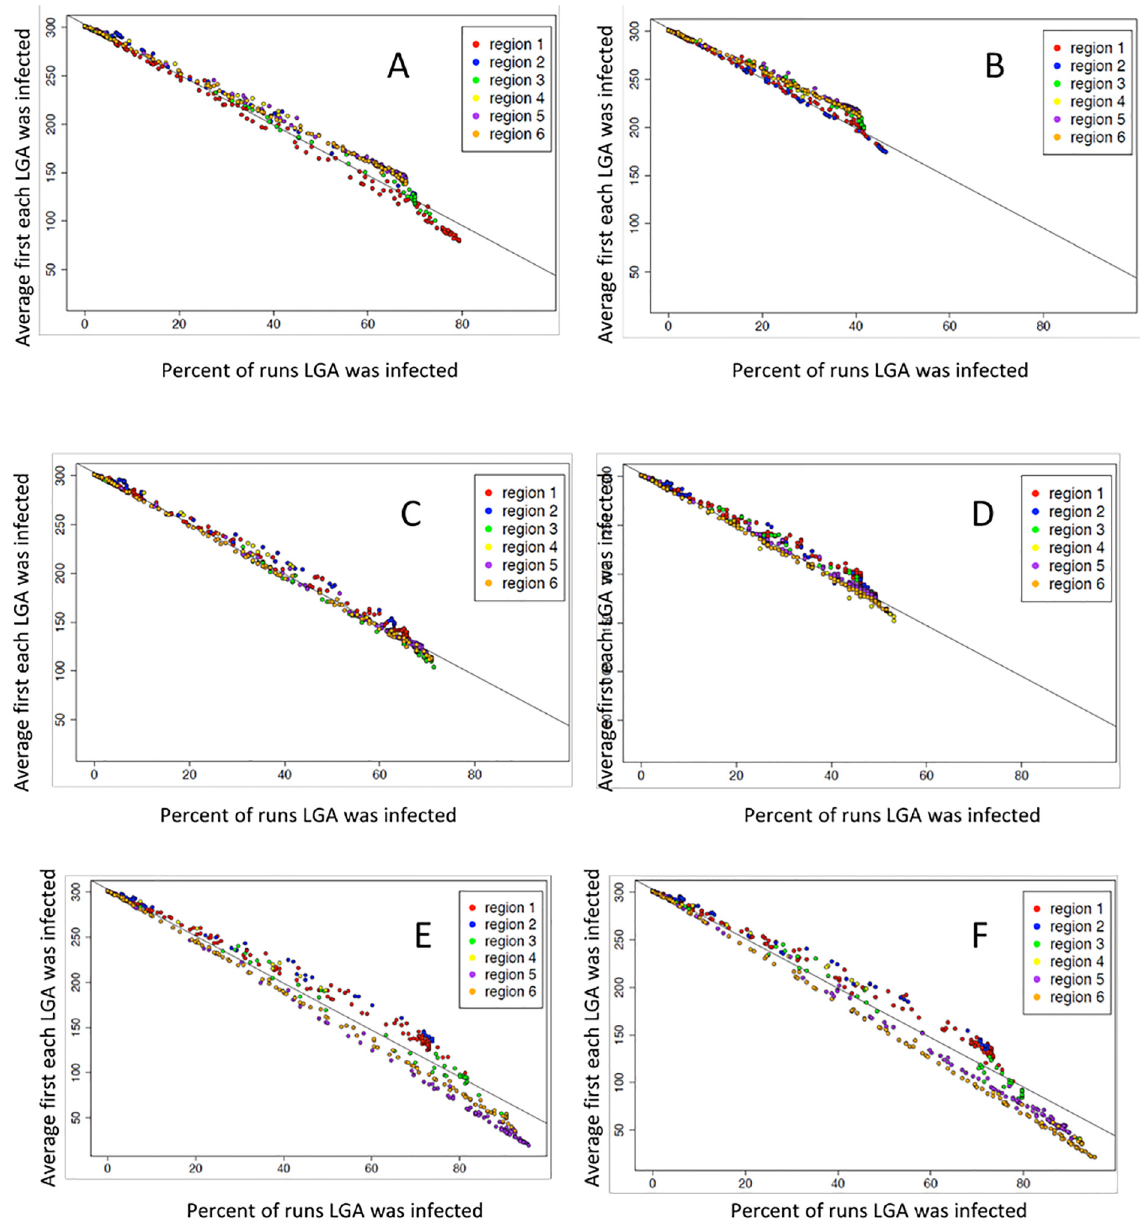
Fig 4. Local Government Associations (LGA) over all simulation runs for the average number of times that each LGA was infected for all the simulations and the average first day a LGA becomes infected for each region where the epidemic is started. Epidemic starts in region A) 1. B) 2, C) 3, D) 4, E) 5, F)